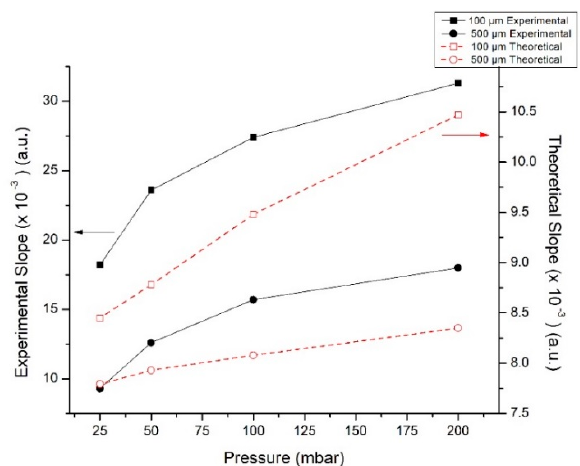
Figure 6. Theoretical and experimental slope of the intensity profile in the diffusion region versus the pumping pressure for two different chamber heights: 100 μ m and 500 μ m.